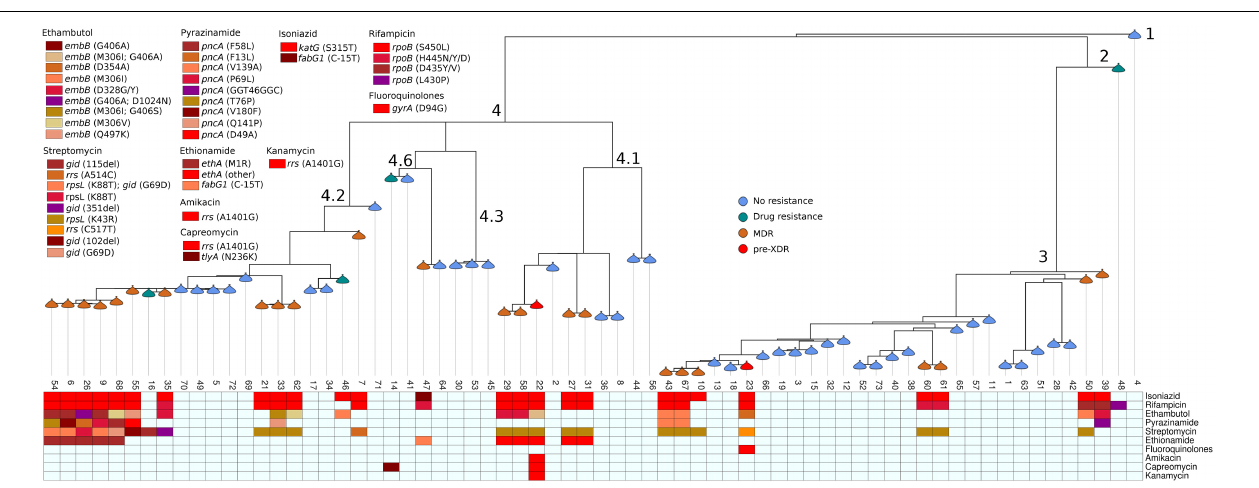
FIGURE 2 | Phylogenetic tree of Mycobacterium tuberculosis isolated from pulmonary tuberculosis patients in Tigray Region, Ethiopia, July 2018 to August 2019. Branches are annotated with lineage, and nodes are annotated with drug resistance patterns. Boxes at the bottom part of the figure display specific anti-tuberculosis resistance-associated